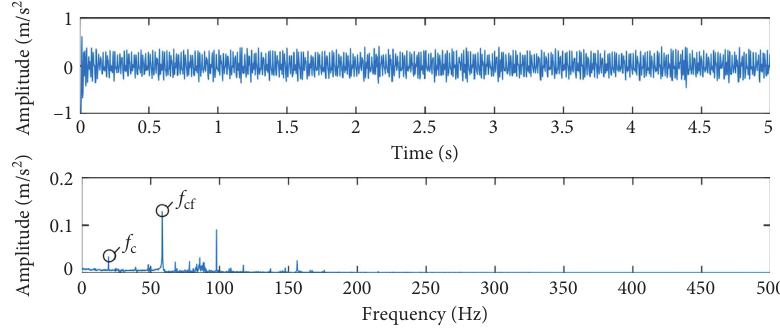
Figure 24: Signal processed by USSR.